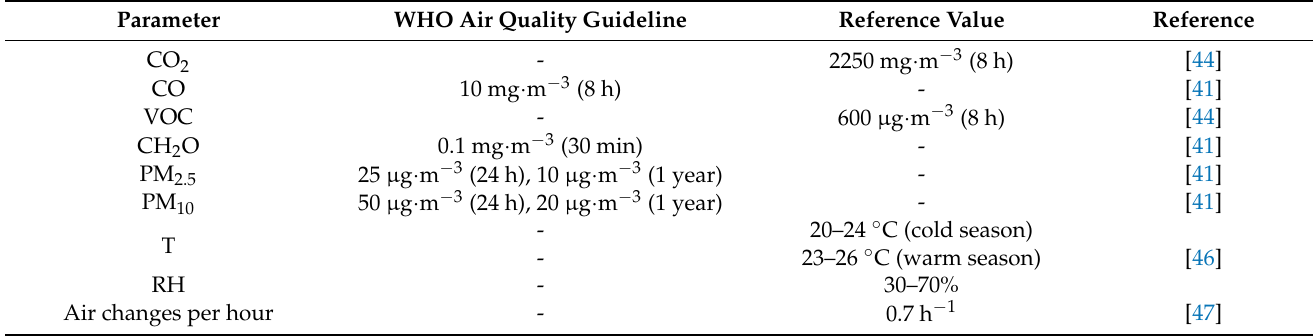
Table 2. Limit values and guidelines for each considered environmental parameter in indoor environments and their source